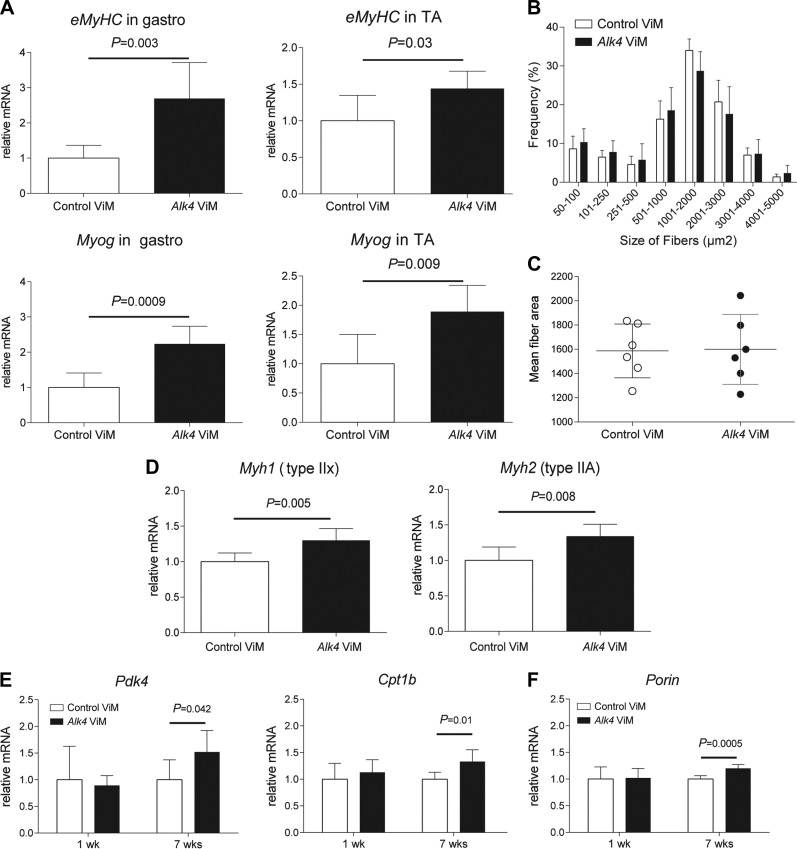
Alk4 down-regulation induces muscle regeneration and fiber-type switch toward oxidative endurance fibers in WT gastrocnemius muscles. A) Myogenic gene expression was measured by qPCR. Significant up-regulation of eMyHC and Myog was found after 7 wk of Alk4 ViM intramuscular treatment in gastrocnemius and tibialis anterior muscles. B) Alk4 ViM-treated gastrocnemius showed a significantly higher number of smaller fibers (50–1000 µm2) and a significantly lower number of larger fibers (1001–5000 µm2) than control ViM-treated muscles. C) The mean fiber area was not significantly changed after treatment with Alk4 ViM. D) A significant up-regulation of MyHC IIx and IIa isoforms was found in Alk4 ViM-treated muscles. E) Gene expression of Pdk4 and Cpt1b was significantly increased after 7 wk of Alk4 ViM treatment. F) The gene expression of Porin was significantly increased at 7 wk in Alk4 ViM-treated muscles. Gene expression levels were normalized to Gapdh and are depicted relative to control-treated muscles. Error bars, sd.